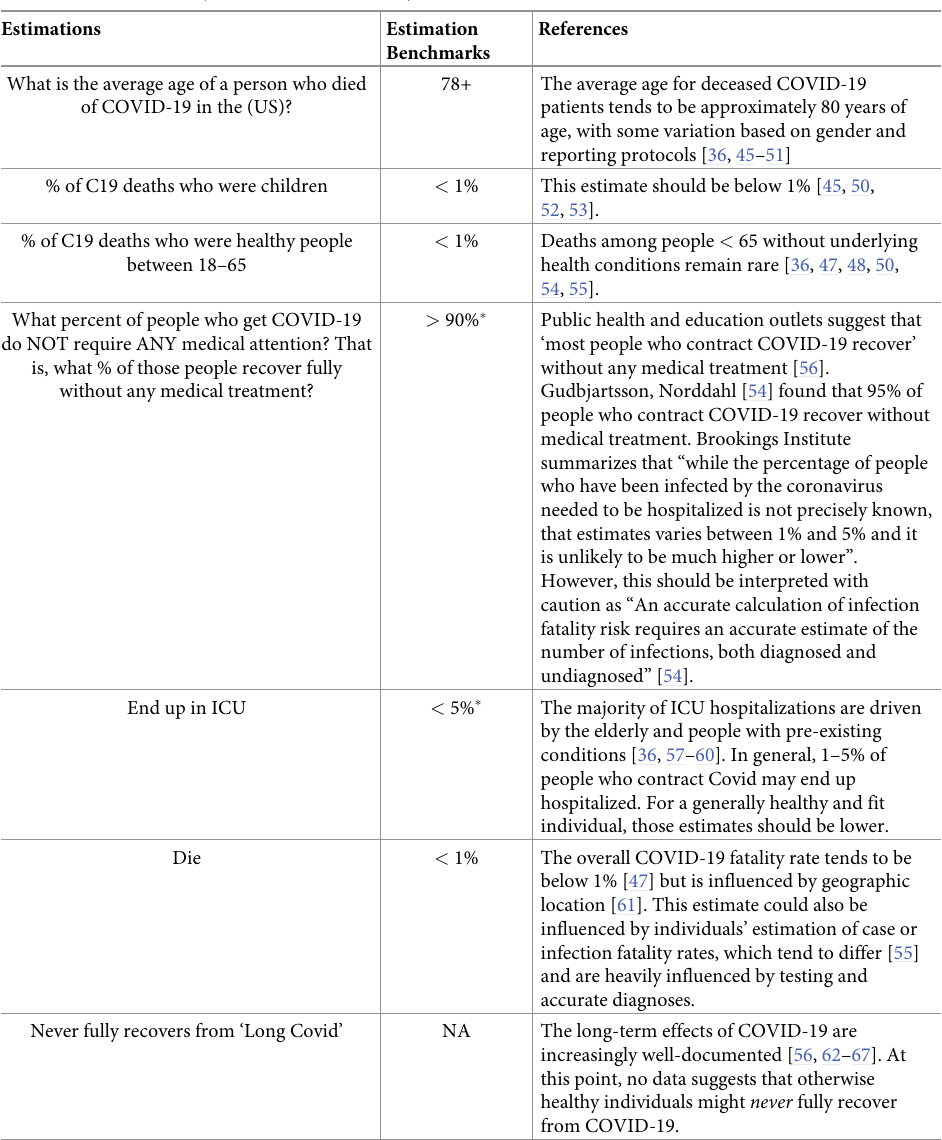
Table 4. Core indicators, estimation benchmarks, and